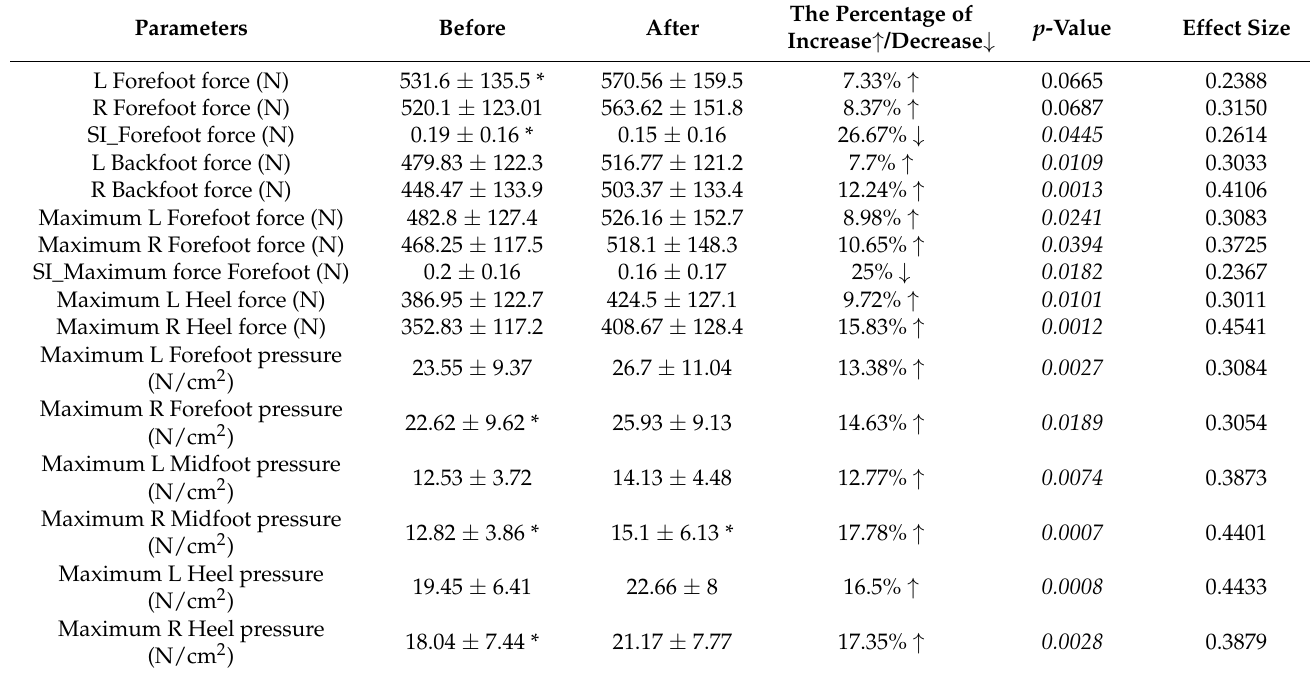
Table 4. Results (mean ± SD) of Wilcoxon test/ t -test ( p < 0.05) and effect size for comparison before and after rehabilitation within the VRG group for force and pressure parameters.